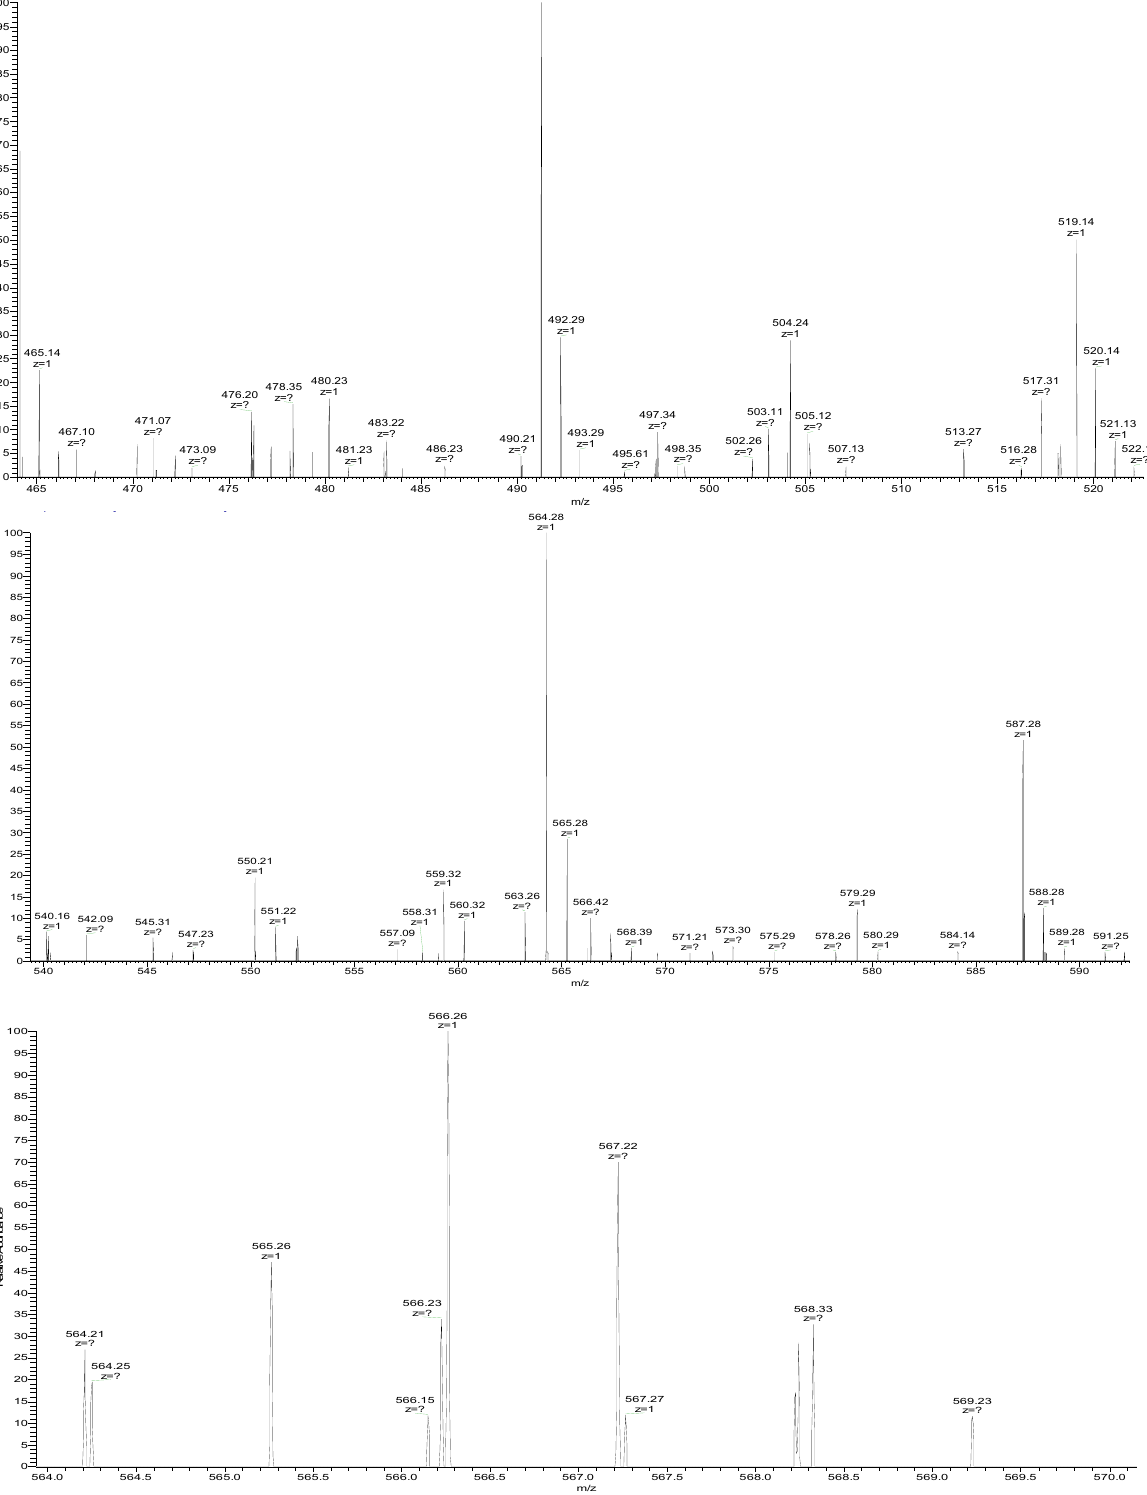
Figure 13. Secondary mass spectra of three novel ACE inhibitory peptides.